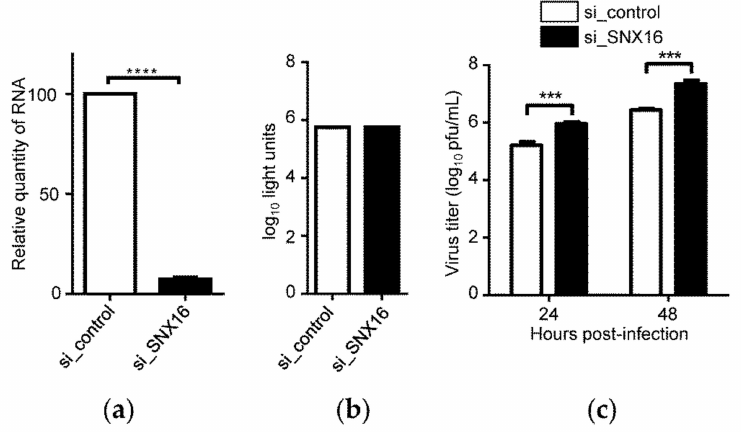
Figure 1. Overexpression of SNX16 inhibits the replication of IAV. ( a ) A549 cells were transfected with empty vector or plasmids expressing Flag-SNX16. The expression of SNX16 was subjected to Western blotting with a mouse anti-Flag mAb. ( b ) The transfected cells as in ( a ) were infected with WSN (H1N1) virus at an MOI of 0.01. Supernatants were collected at the indicated time points to determine the virus titers by plaque assay ( n = 3). ***, p < 0.001; ****, p < 0.0001. Data are representative of three independent experiments.